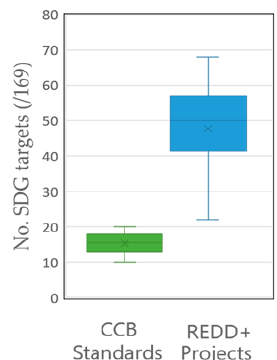
Figure 2. The number of Sustainable Development Goals targets correlating to the Climate, Community and Biodiversity Alliance (CCB) Standards (Second and Third Editions and Gold Standards) and the number of SDG targets supported by Reducing Emissions from Deforestation and Degradation (REDD+) projects in their project design documents. Maximum and minimum values, interquartile range, median line, and cross indicating the mean value of SDG targets that are supported by the Standards and REDD+ projects.